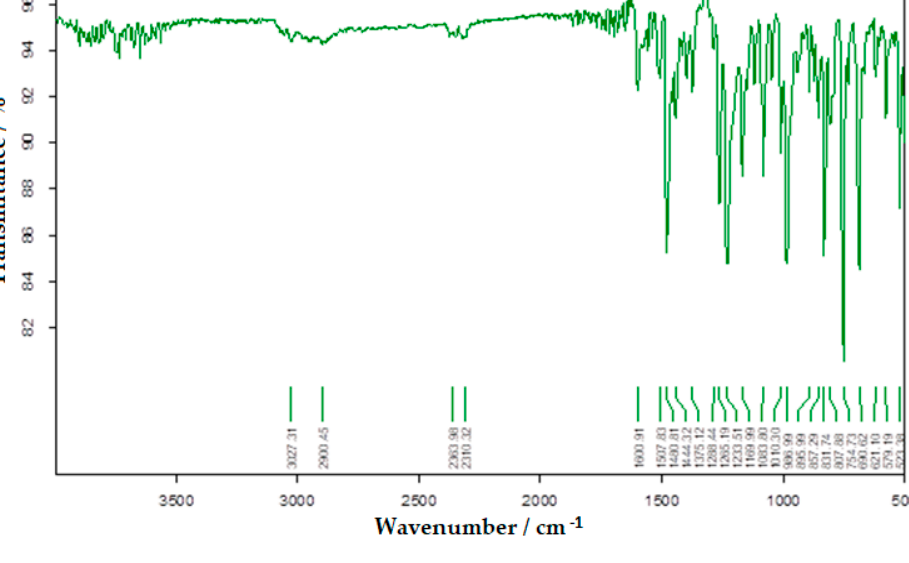
Figure 5. The FTIR spectrum of BPA.